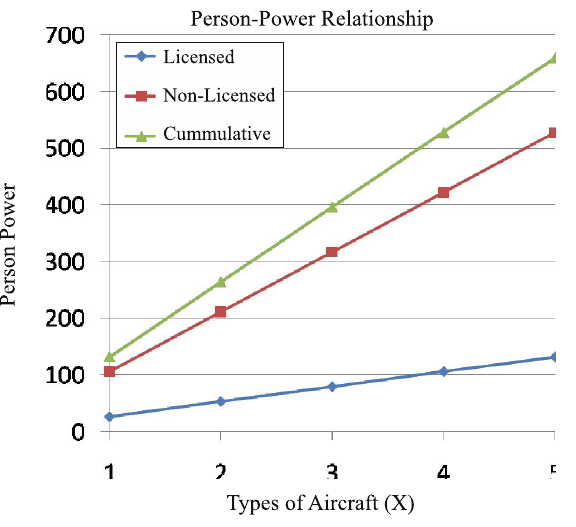
FIG. 2. PERSON-POWER RELATIONSHIP VS AIRCRAFT FIG. 3. COST OF PERSONNEL RELATIONSHIP VS AIRCRAFT TYPES IN EXISTING SETUP TYPESIN EXISTING SETUP TABLE 2. COST OF PERSONNEL IN EXISTING